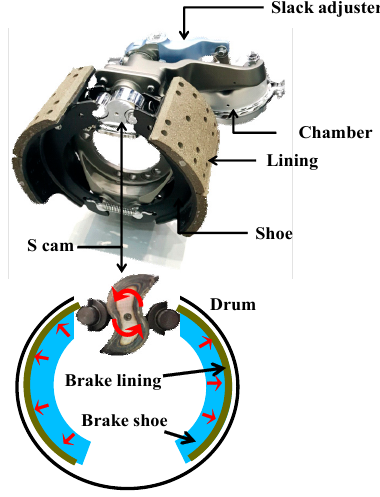
Figure 2. Illustration of a pneumatic drum brake system.